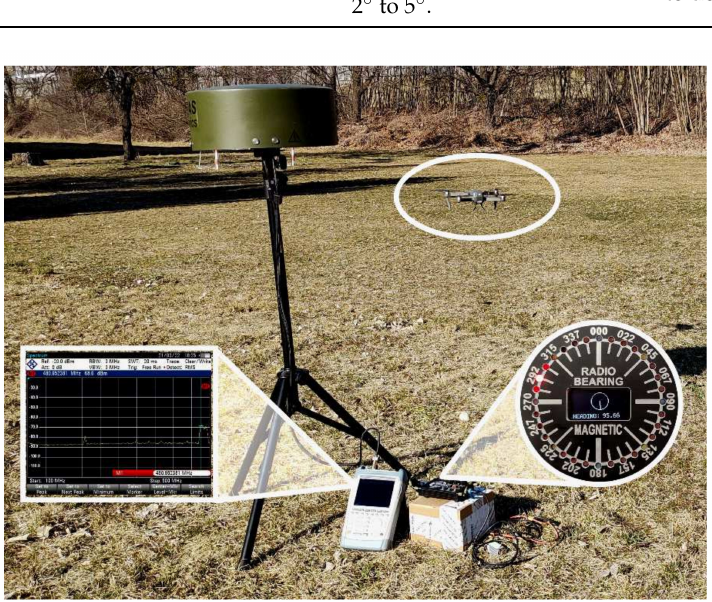
Figure 1. The model situation of UAV localisation with IDVOR system in the local area. Spectrum analyser is used for signal detection, and the LED signalisation on the control panel presents the direction of the tuned signal